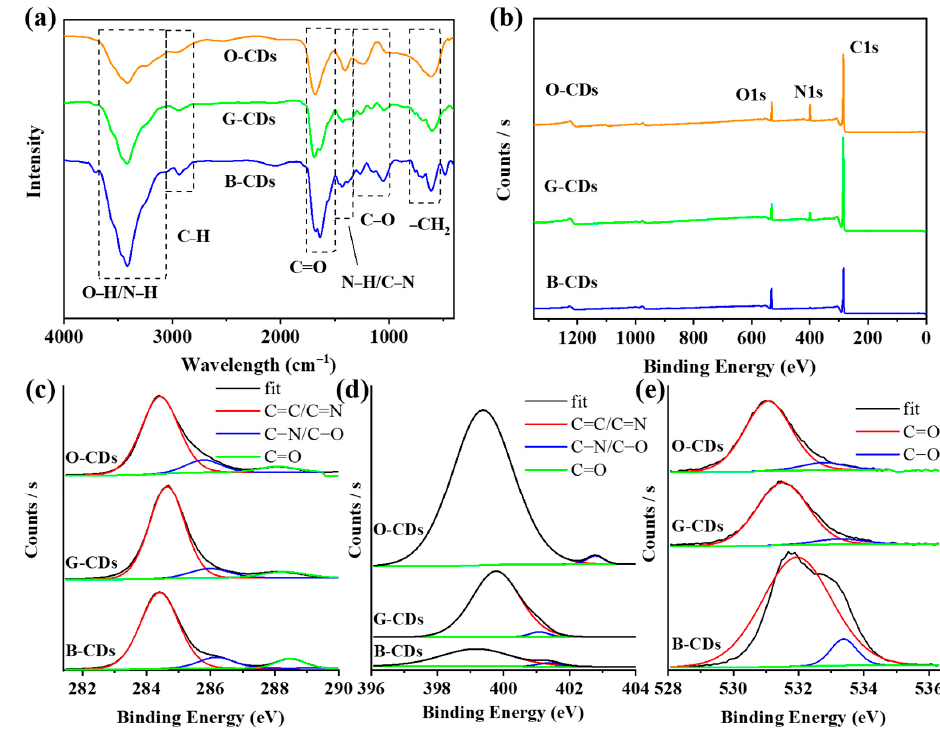
Figure 6. ( a ) FTIR spectra of CDs. ( b ) XPS survey spectra and ( c – e ) high-resolution C1s and O1s spectra of CDs.